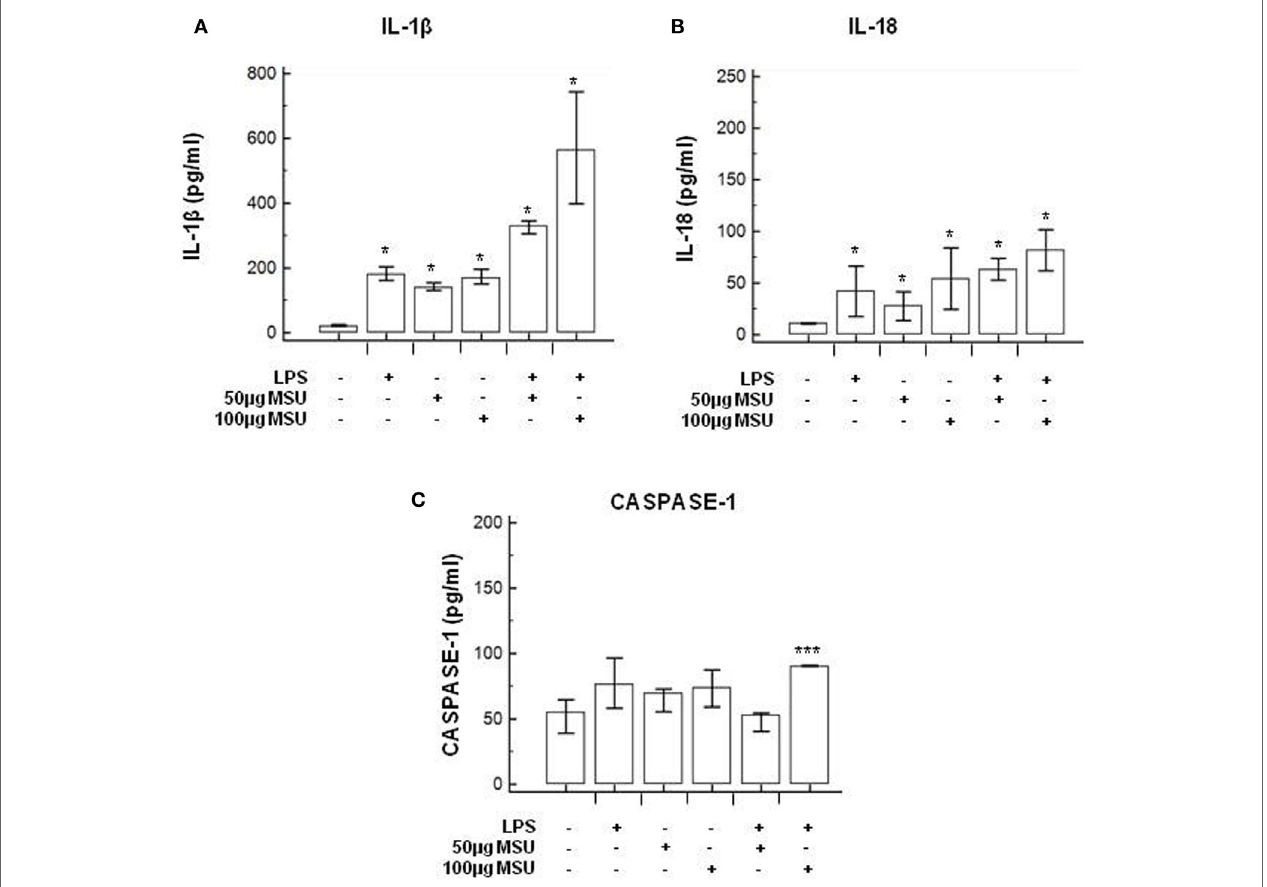
FigUre 5 | Modulation of inflammasome effector proteins by monosodium urate crystals (MSU) in PBMCs of HC subjects. PBMCs of HC subjects were stimulated with lipopolysaccharide (LPS) (1 µg/ml) for 2 h and/or with the indicate concentration of MSU crystals for 22 h. IL-1 β (a) , IL-18 (B) , and caspase-1 (c) were quantified in supernatants by ELISA. Data are representative of three independent experiments and expressed as means ± SD. * p < 0.05, ** p < 0.01, *** p < 0.001 significant difference from cells